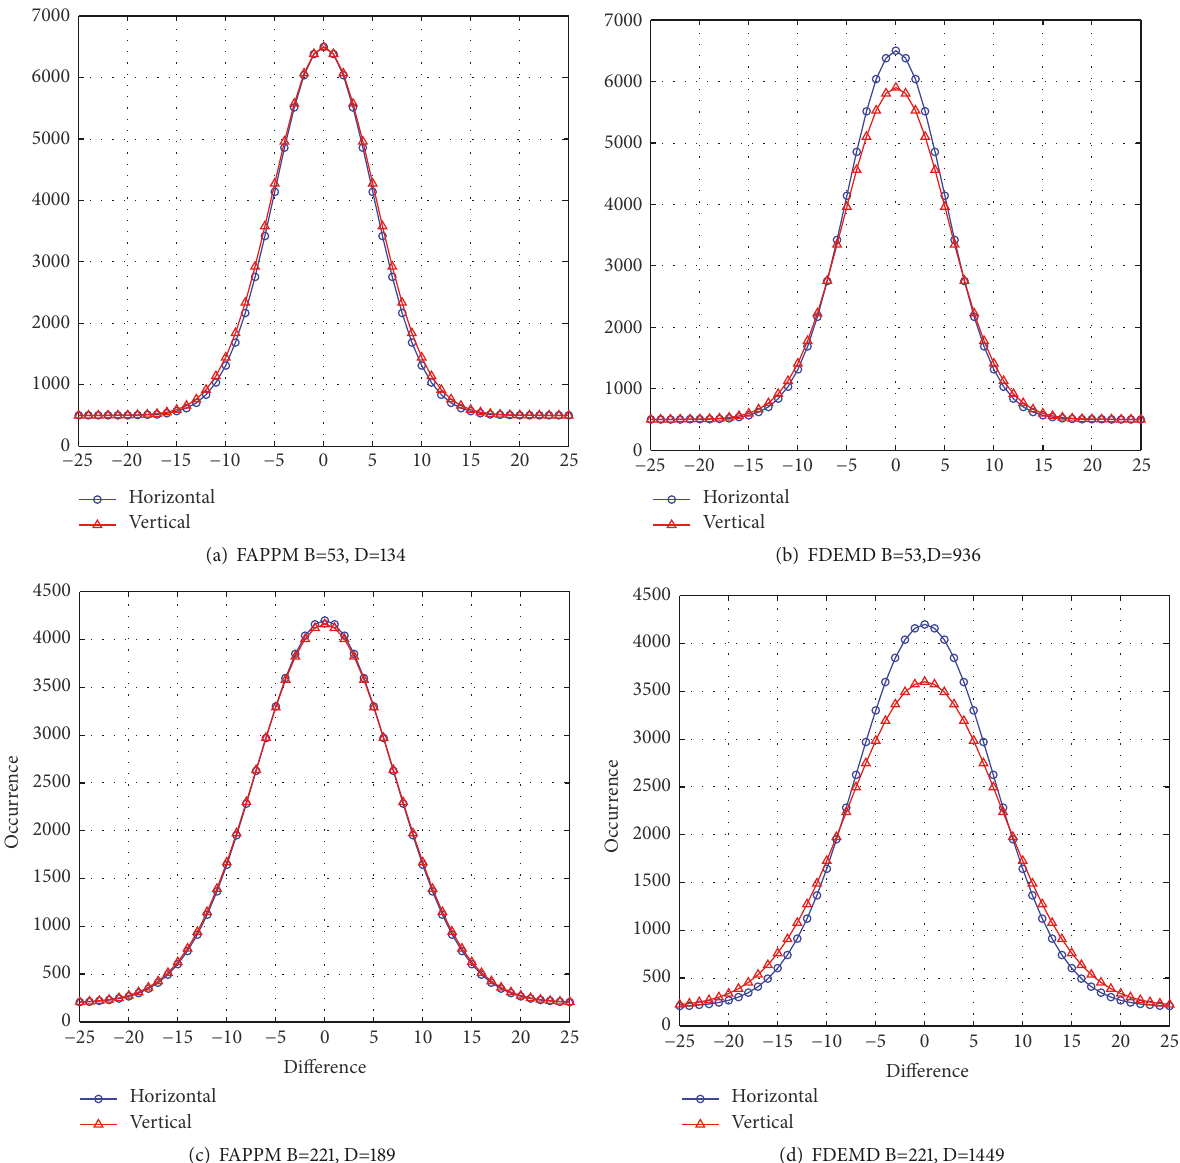
Figure 6: Comparison of the averaged vertical and horizontal difference histograms of FAPPM and